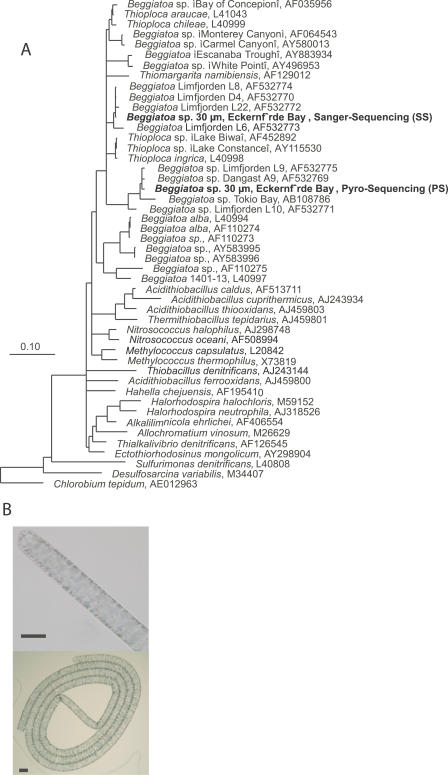

Beggiatoa Sp. Phylogeny and Morphology(A) Phylogenetic reconstruction based on the 16S rRNA genes encoded on the PS and SS datasets. Branching orders that were not supported by all methods are shown as multifurcations. Partial sequences were subsequently inserted into the reconstructed consensus tree. The scale bar corresponds to 10% estimated sequence divergence.(B) Micrographs of two multicellular filaments of vacuolated Beggiatoa from Eckernförde Bay/Baltic Sea. Scale bars correspond to 30 μm.